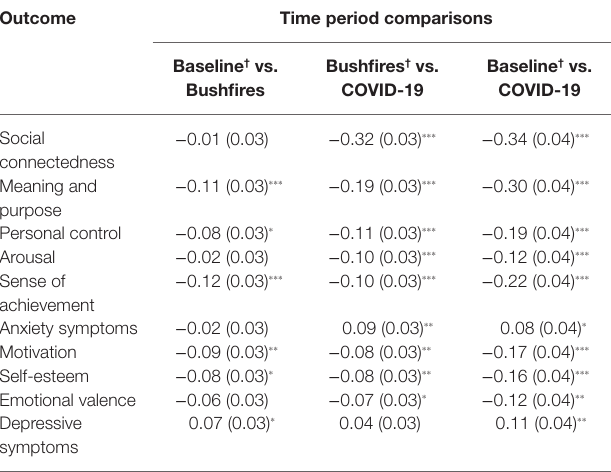
TABLE 1 | Partially standardized coefficients (standard errors) for individual multilevel models (MLMs) comparing average outcome scores across the baseline, bushfire, and COVID-19 time